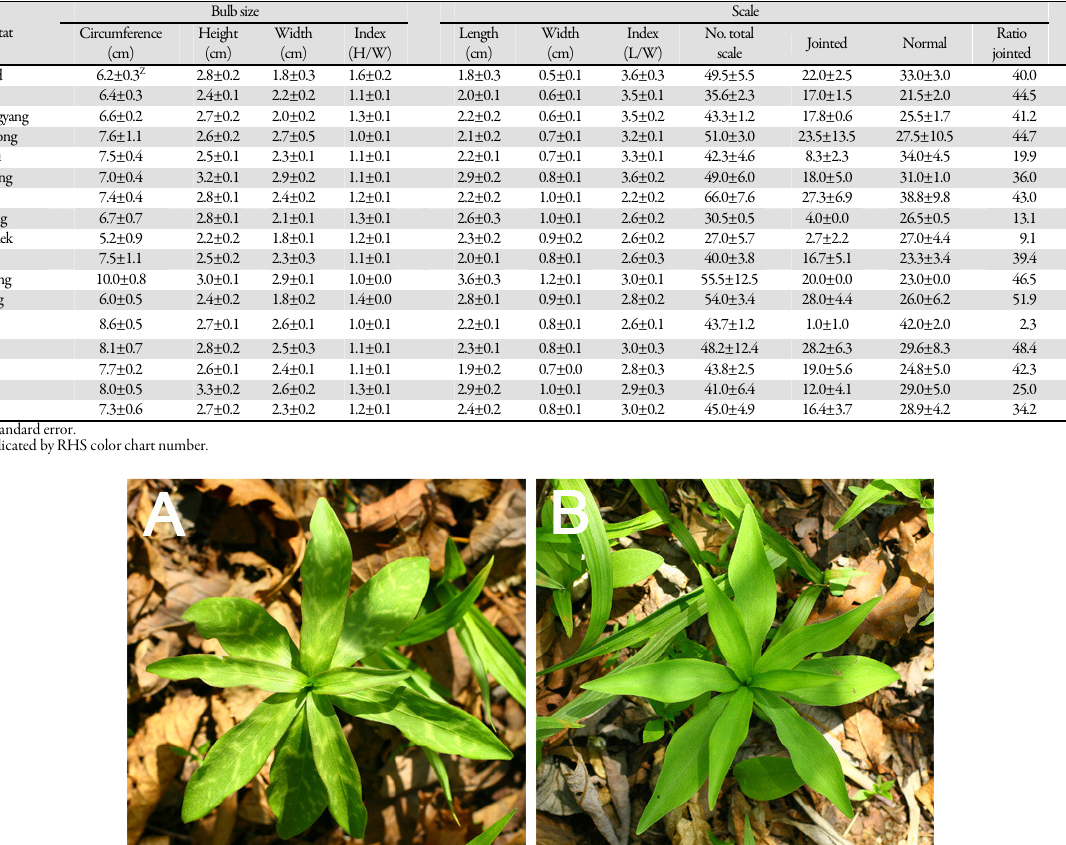
Fig. 3. Leaf morphology and mosaic of individuals of L. tsingtauense found in Korea. A: mosaic type, B: without mosaic